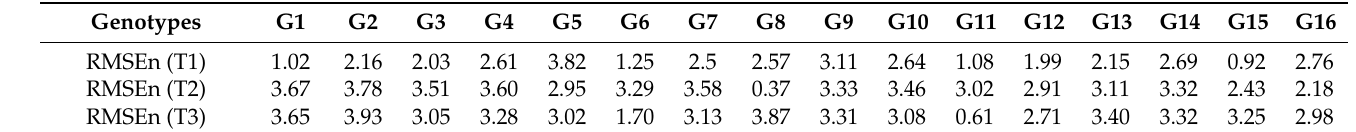
Figure 5. Simulated versus observed days to anthesis ( a ) and days to maturity ( b ) for sixteen upland rice genotypes under T1: control (100% FC), T2: moderate stress (70% FC), and T3: severe stress (50% FC) treatments in the yield assessment experiment.